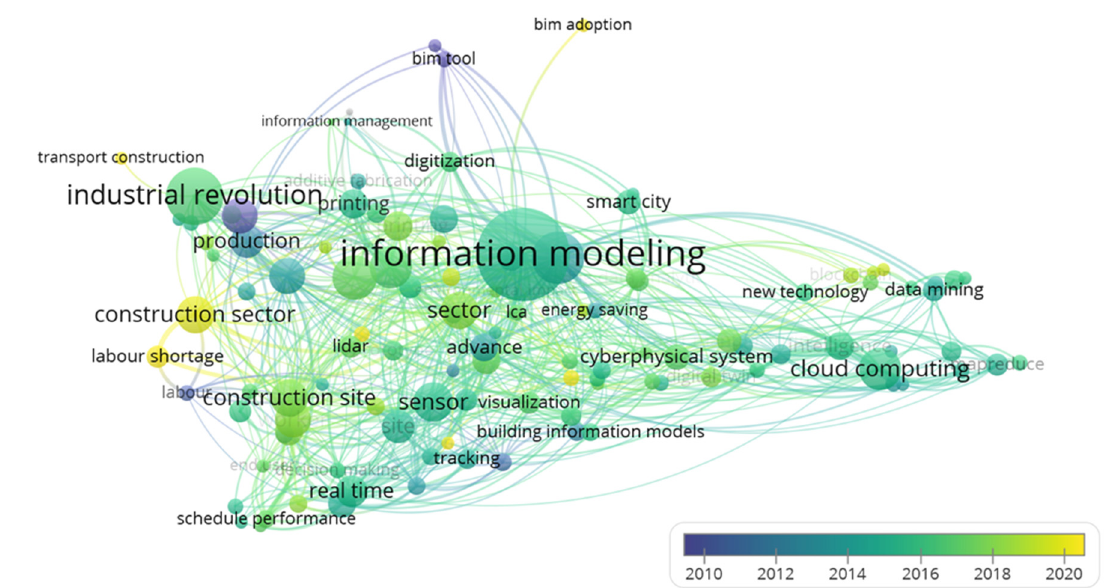
Figure 2. Network map of referenced keyword clusters.